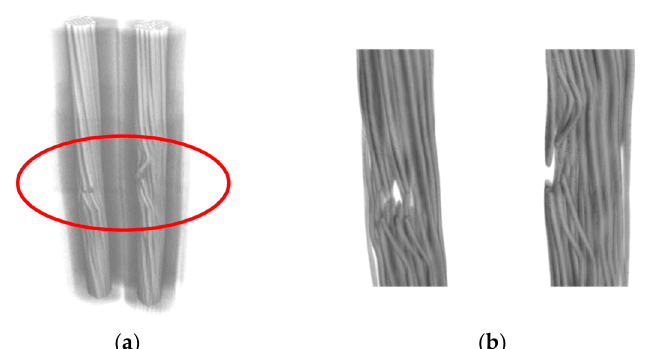
Figure 3. Example of X-ray computed tomography image. ( a ) overall image ( b ) magnified image of circled part in ( a ).